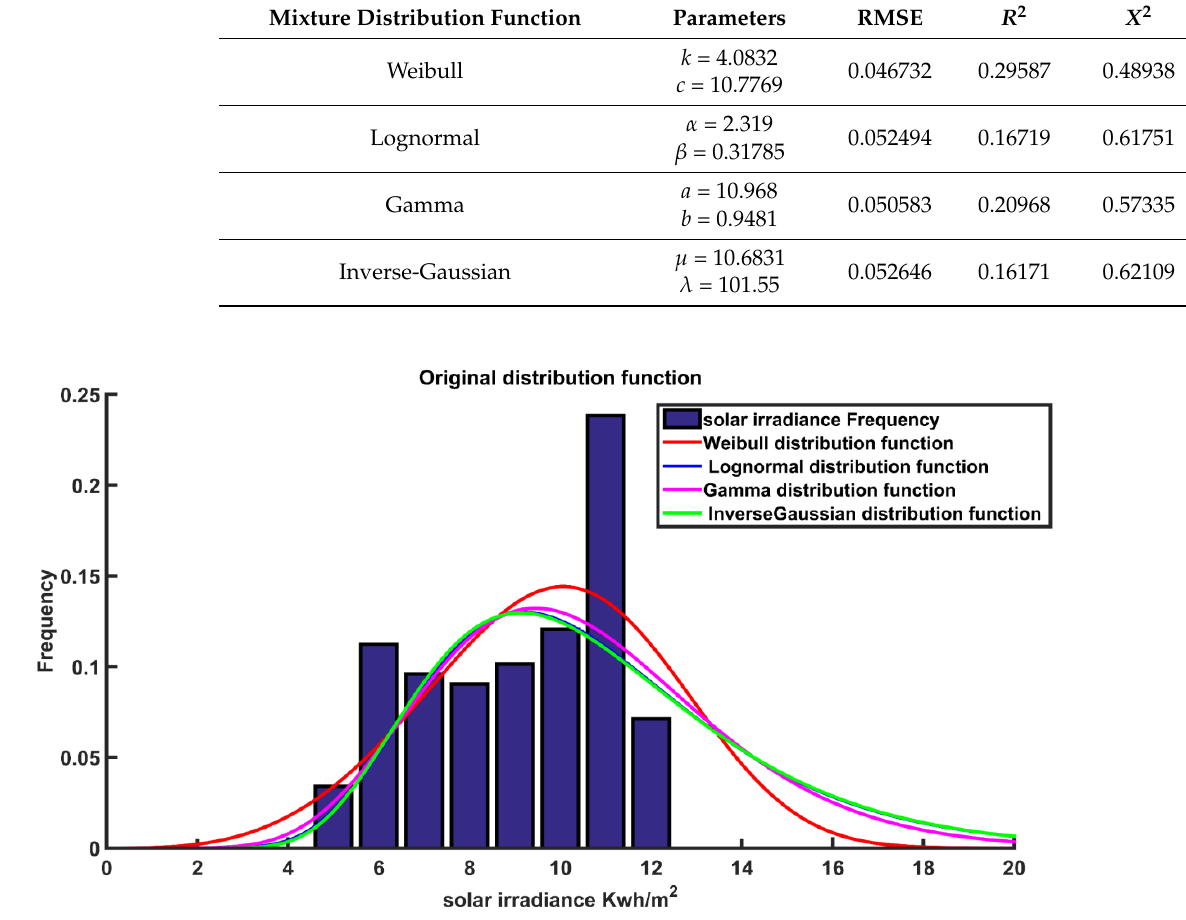
Figure 5. The original distribution function in the solar irradiance modeling.